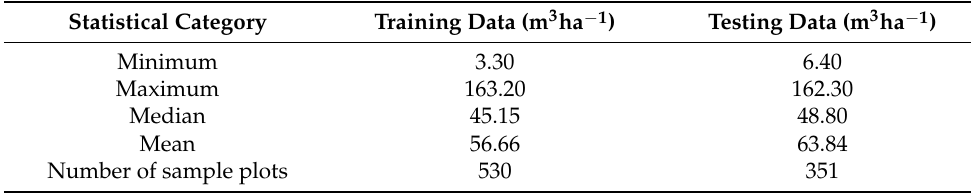
Table 1. Descriptive statistics of the FSV training and testing data.